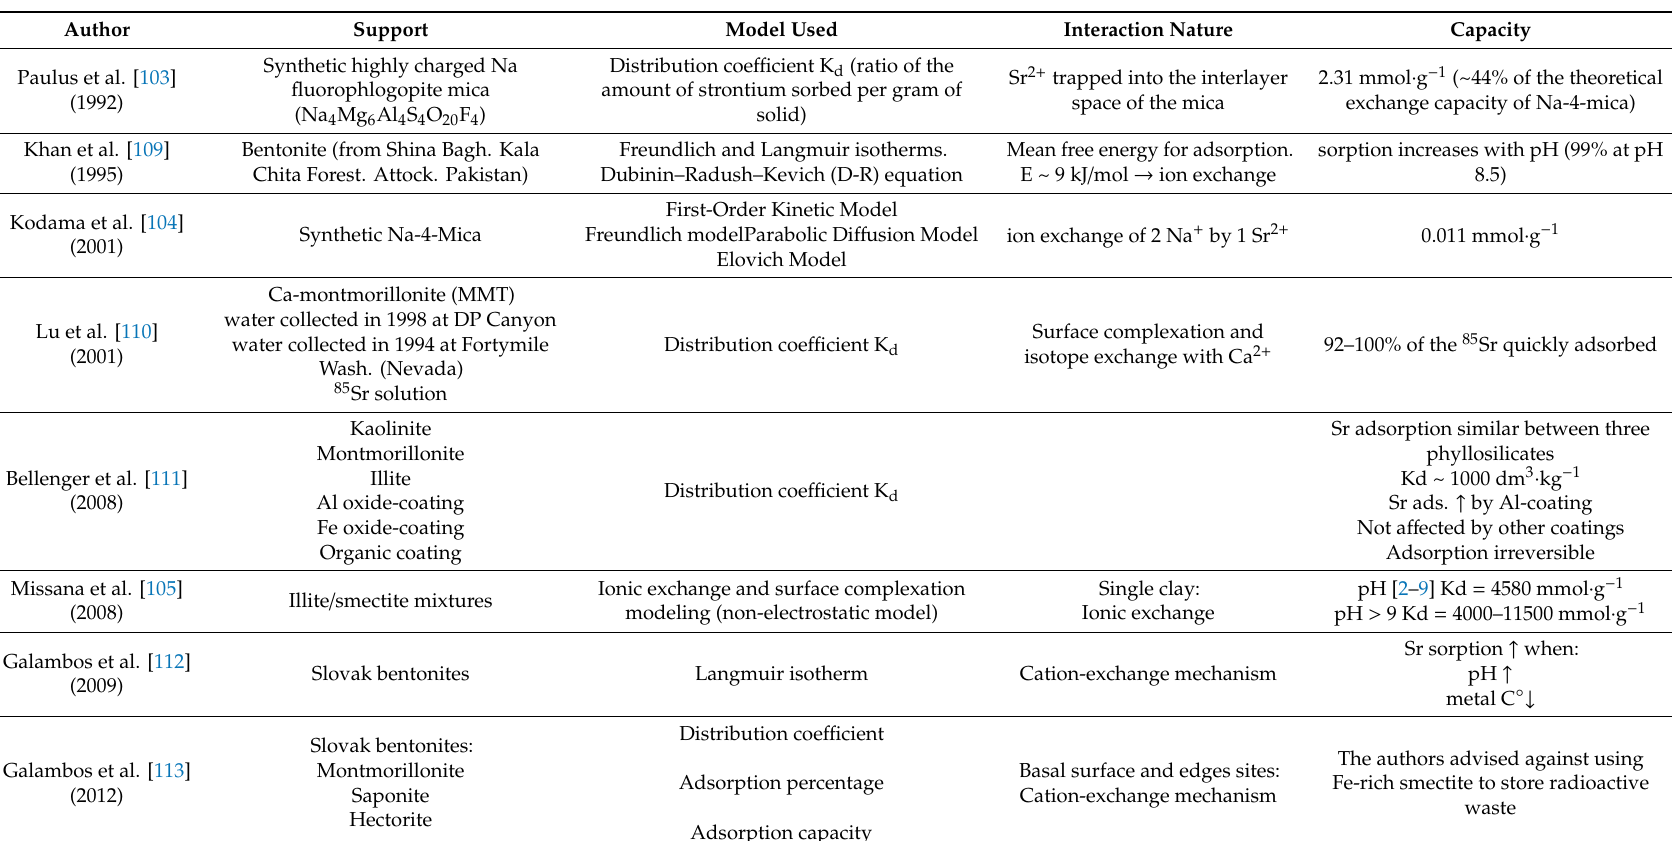
Table 4. Summary of di ff erent approaches to entrap strontium on phyllosilicates, model used, type of interaction and retention